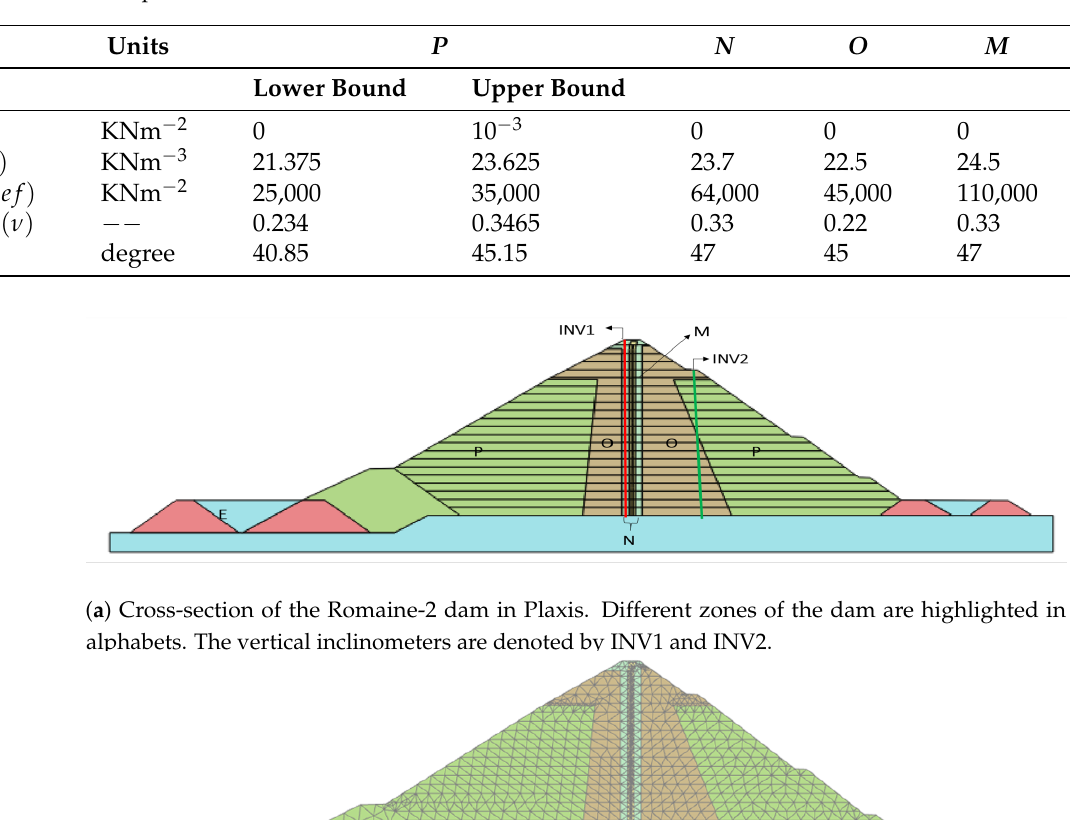
Table 1. Soil parameter values or intervals of variations for zones P, N, O and M.